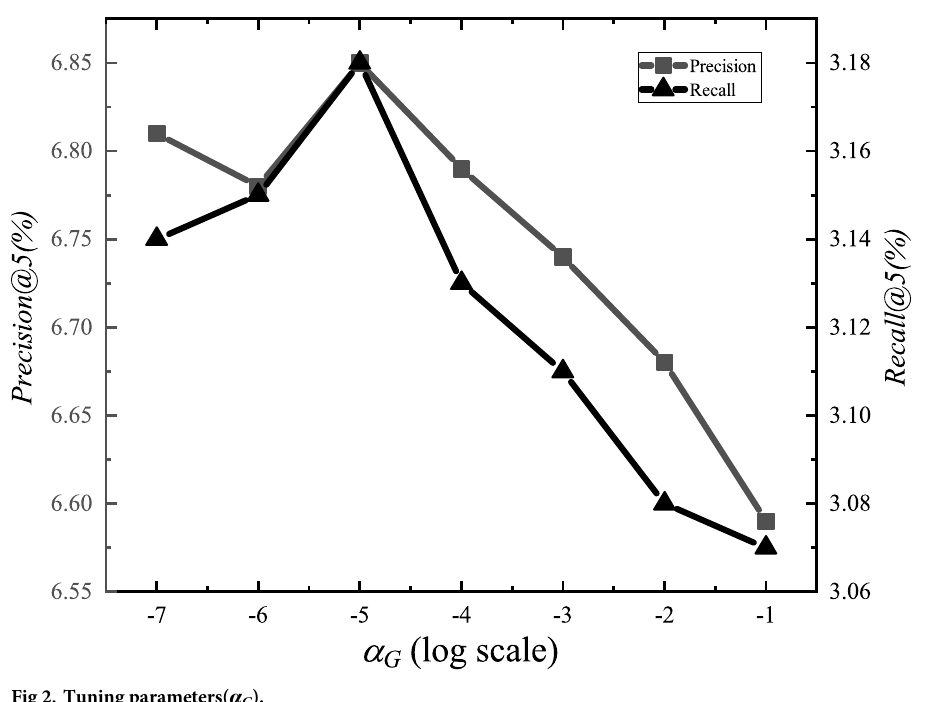
Fig 1. Tuning parameters( α